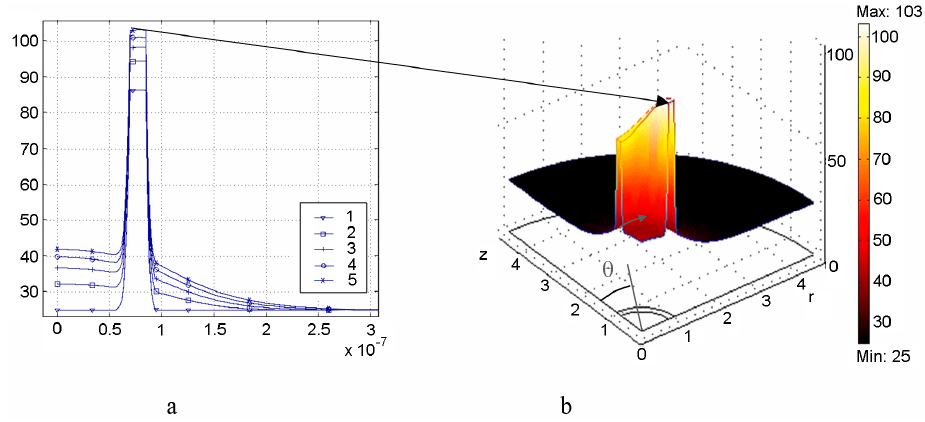
Figure 5. The temperature T distributions in the spherical nanoshell (with SiO 2 core of a radius R = 70 nm and a gold coating of thickness 15 nm) in the water environment irradiated by a series of five pulses of a rectangular shape. The duration of each pulse is 50 ps, repetition rate is 10 ns, the intensity of radiation at a wavelength 800 nm is 4.5 MW/cm 2 : radial dependences of T at the times of turn-off of j- th irradiating pulse, j = 1/5 ( а ); two-dimensional distribution of T at the end of the 5th irradiating pulse (due to symmetry only 1/4 of the total allocation is presented) ( b ). The angle θ is measured from the axis z , directed along the polarization vector of the incident field. These Figures are from [53] with permission of the Publisher.